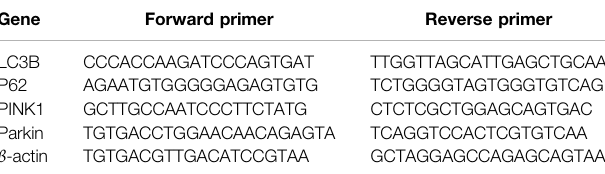
TABLE 1 | | Sequences of primers for real-time